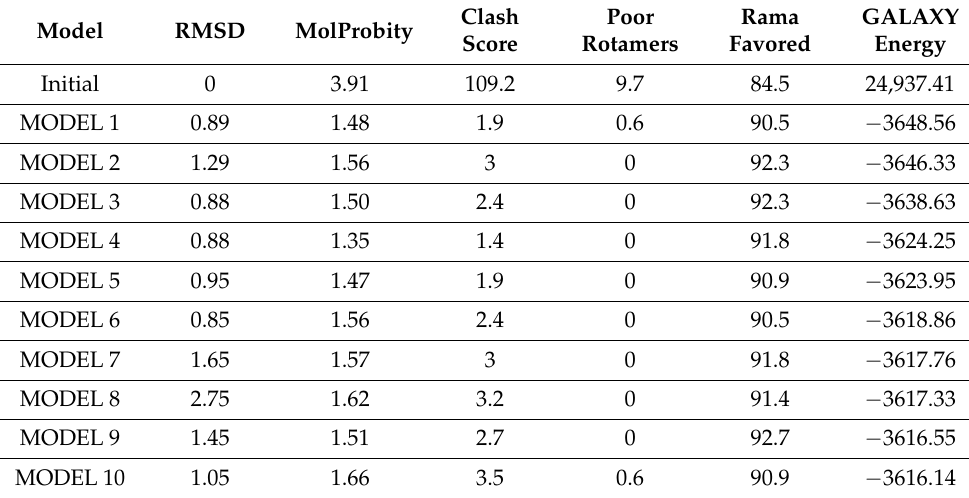
Table 3. Refined vaccine models together with different parameters. The refined models are ranked on basis of galaxy